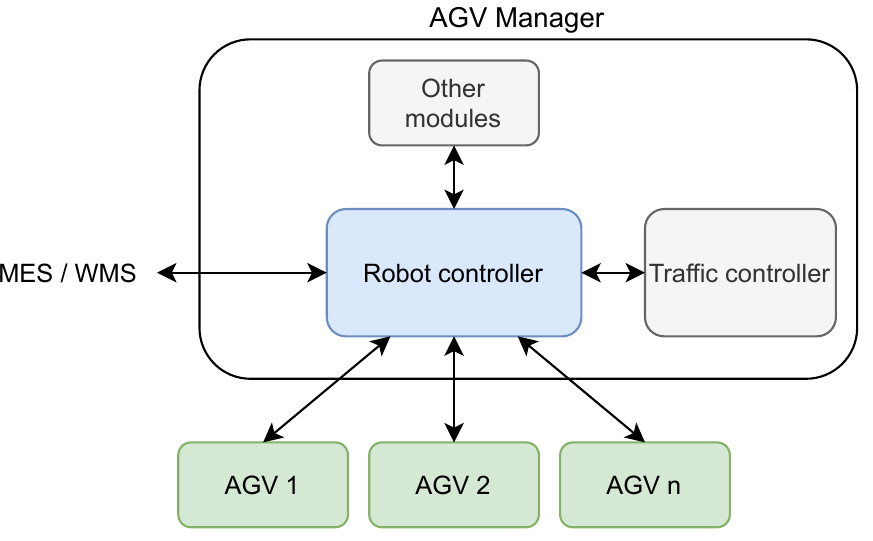
Figure 1. General architecture of the AGV Manager